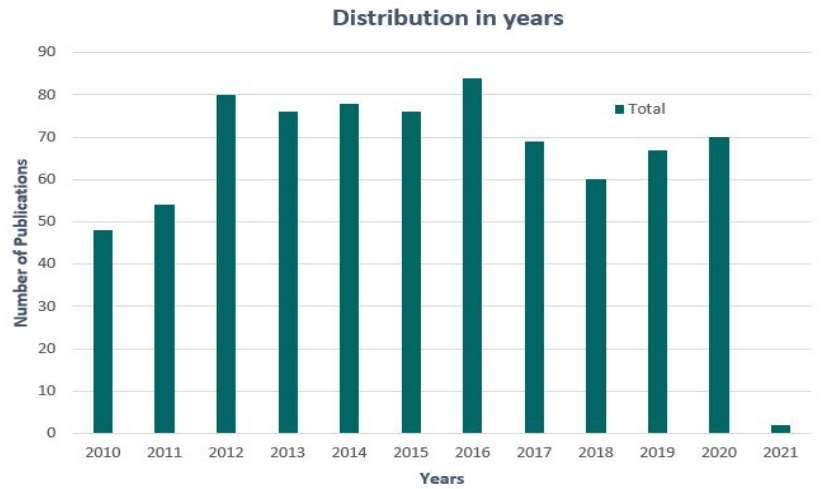
Figure 2. Article distribution in years extracted from 2010 to 2021.